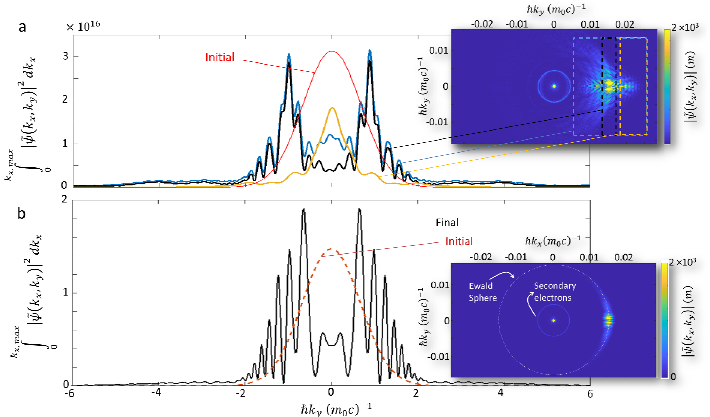
Fig. 3. The lateral distribution of the electron probability integrated over the longitudinal momentum ranges displaced at the inset, for the sample (a) illuminated, and (b) not excited with the